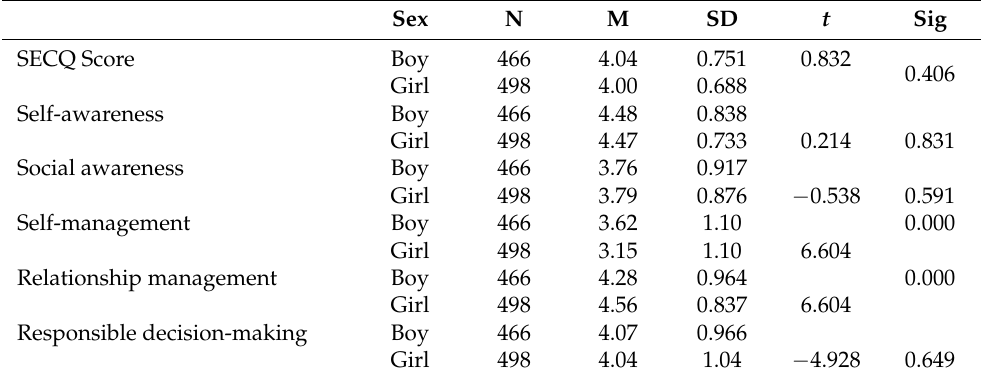
Table 3. Student’s t -test results for the sex variable in